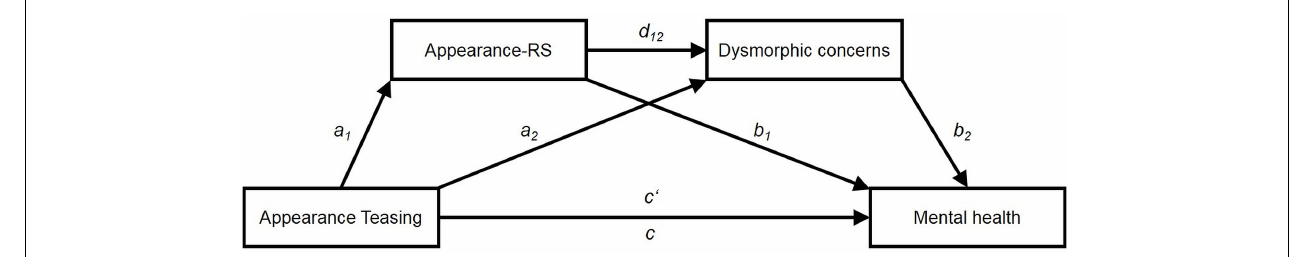
FIGURE 1 | Conceptual mediation model. Appearance-RS, appearance-based rejection